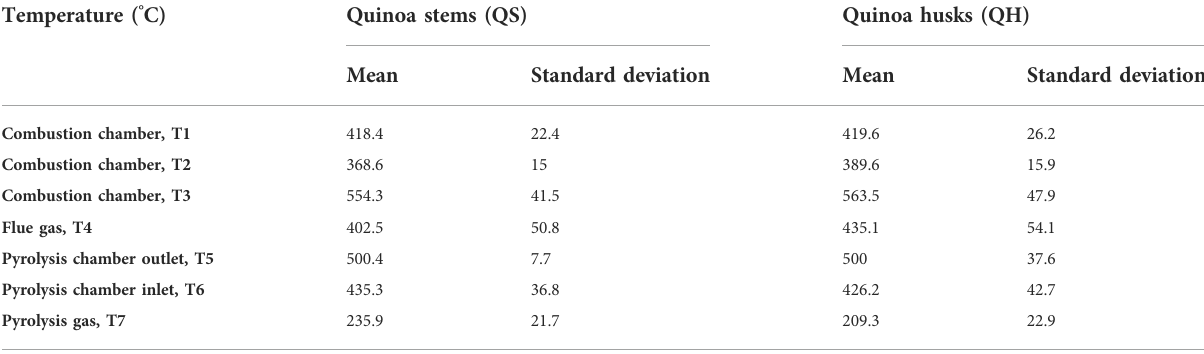
TABLE 3 Temperatures (mean and standard deviation) observed during the pyrolysis process of QS, and QH in the pilot-scale auger-type reactor. Location of thermocouples in the reactor is shown in Fig.2. Temperature ( ° C)